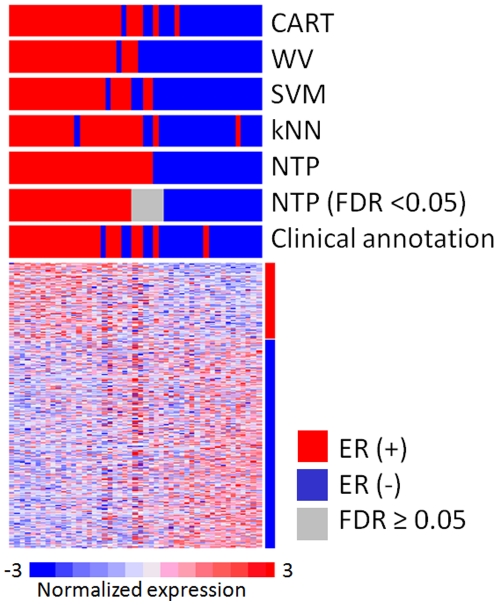
Example 2: Cross-platform prediction of estrogen receptor (ER) positivity in breast cancer.The ER signature was defined and tested on a pair of independent training (N = 97) and test (N = 49) datasets generated on different microarray platforms (see Table 1 for details). Samples are ordered according to proximity to either of the template of ER (+) or ER (−).